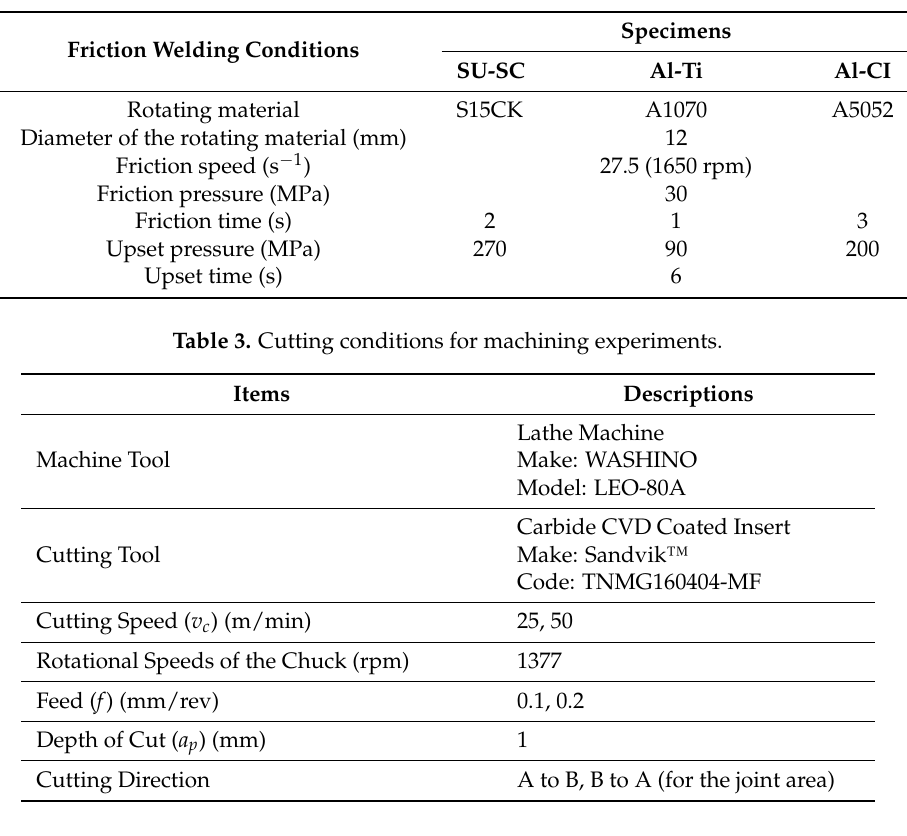
Table 2. Friction welding conditions for fabricating the dissimilar metallic specimens.